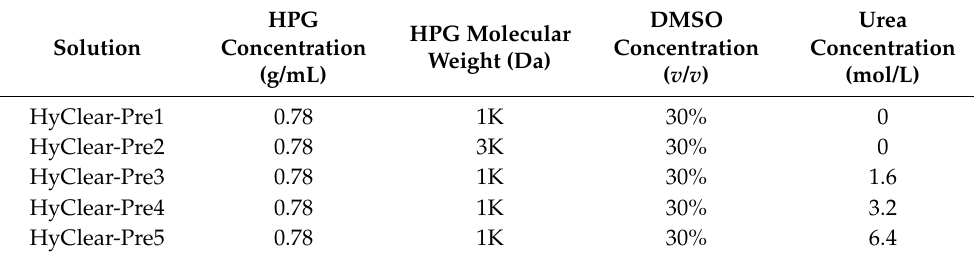
Table 1. The different formulations tested for optimizing